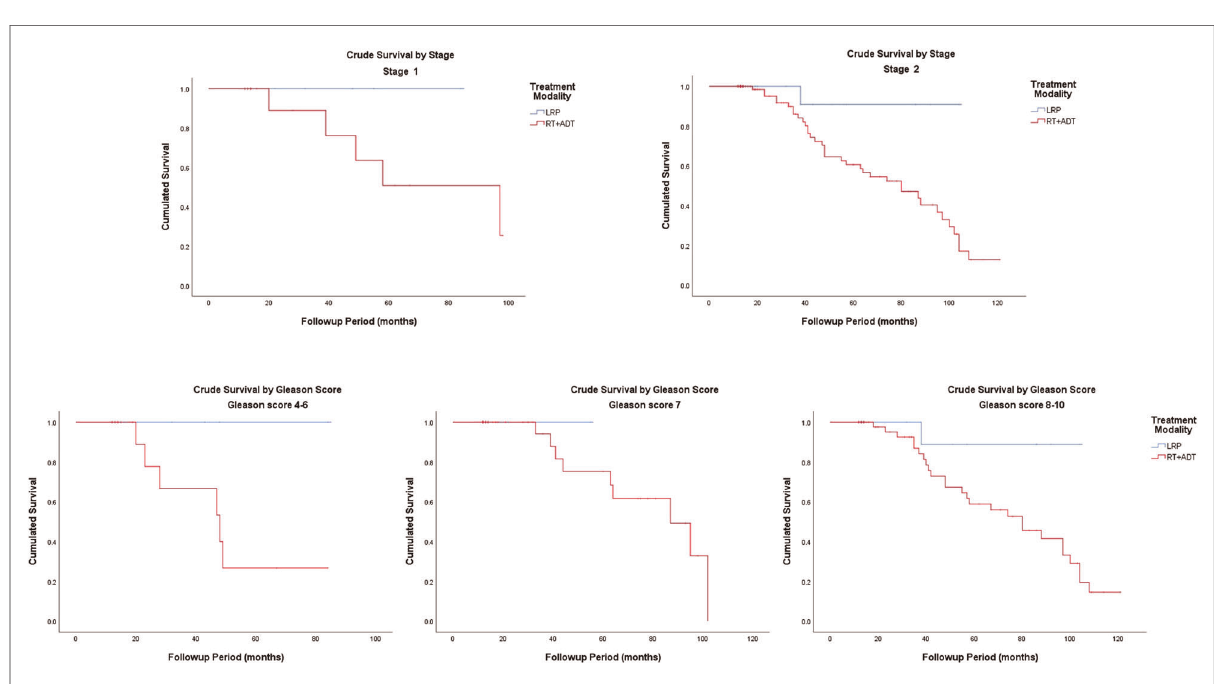
FIGURE 2 Crude survival by stage and Gleason